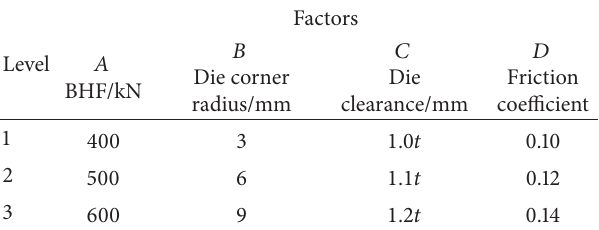
Table 2: Factors and levels of orthogonal experiment.